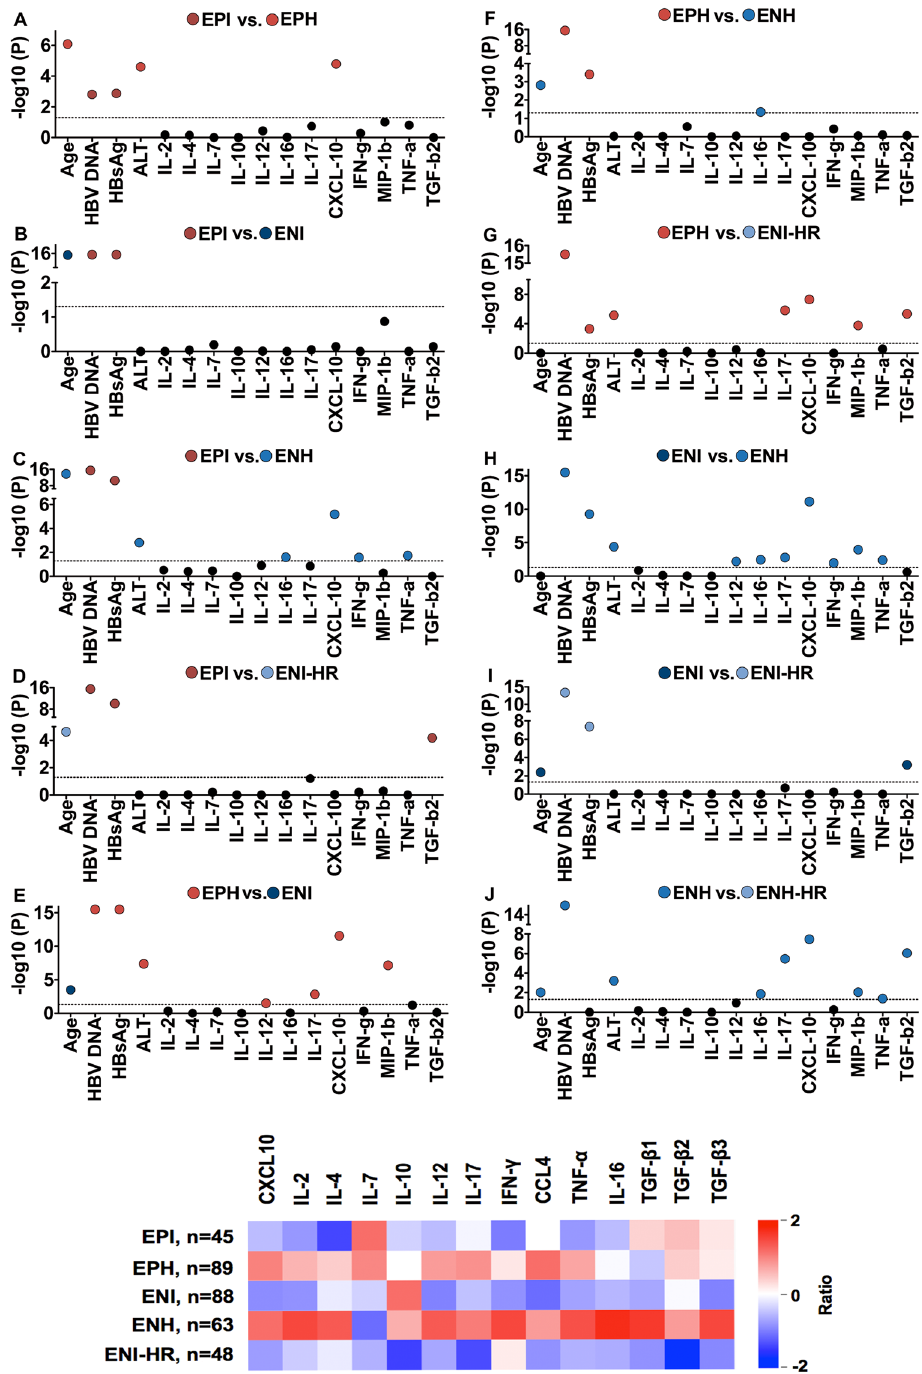
Figure 2. SIM in phases of chronic HBV. ( A ) Significance evaluation of different virological, biochemical and immunological markers between phases of chronic HBV infection. The broken line indicates the significance threshold. Nonsignificant differences are marked with black dots. Significant differences are marked with a colored dot. Colored dots according to group color connotes significantly higher values of the parameter in this group compared to the other group. ( B ) Heat map showing the expression pattern of 14 soluble immune markers normalized by setting mean = 1 and variance = 0. The elements are colored according to the value of each SIM for each